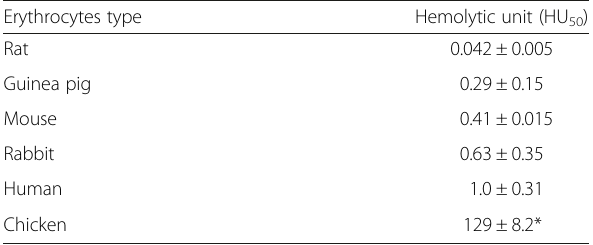
Table 1 Hemolytic activity of the M. alcicornis extract on several types of